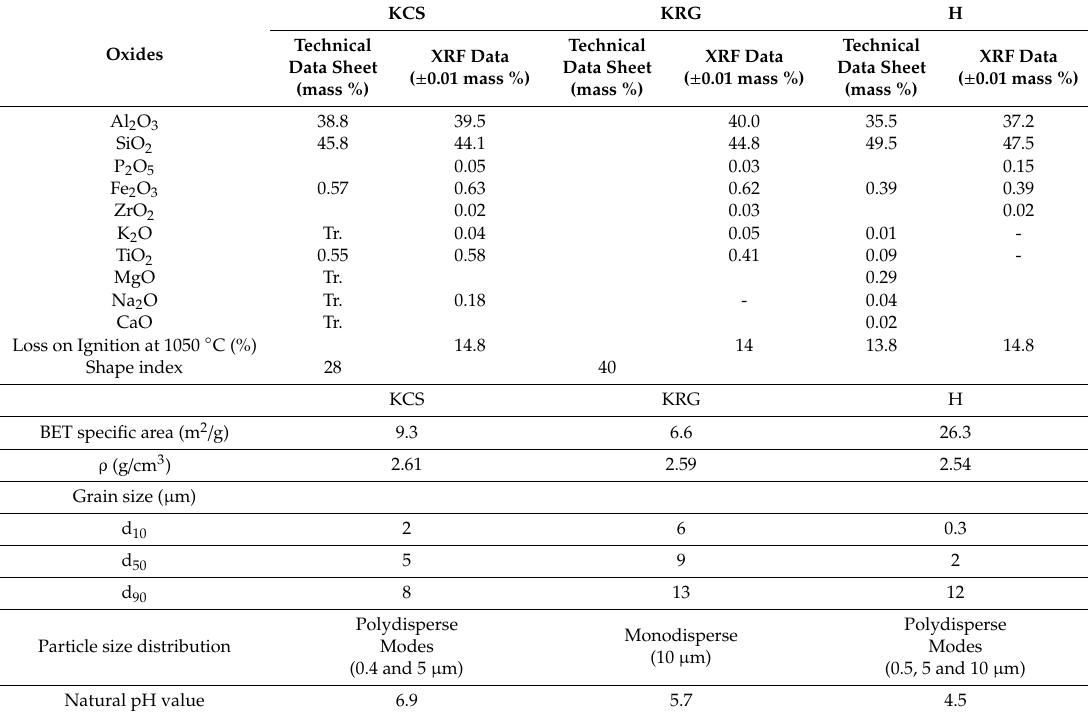
Table 1. Chemical and physical characteristics of raw materials (Tr.: < 0.2 mass